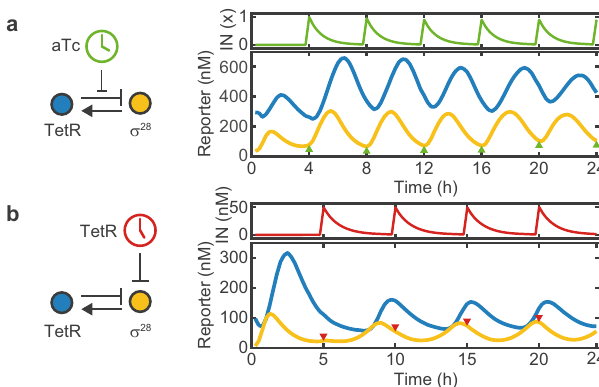
Fig. 4 Dynamics of the forced oscillator. Here, we either added ( a ) 1 × = 214 nM aTc every 4 h ( λ = 1.43), or ( b ) 50 nM TetR every 5 h ( λ = 1.48). Once added, the input signals are removed by the dilution with fresh reagent (without input), which results in an exponential decay of the input signal. The oscillator responds by increasing, or decreasing the production of σ 28 , respectively, and synchronizes to the input period. Colored triangles indicate the time points of input